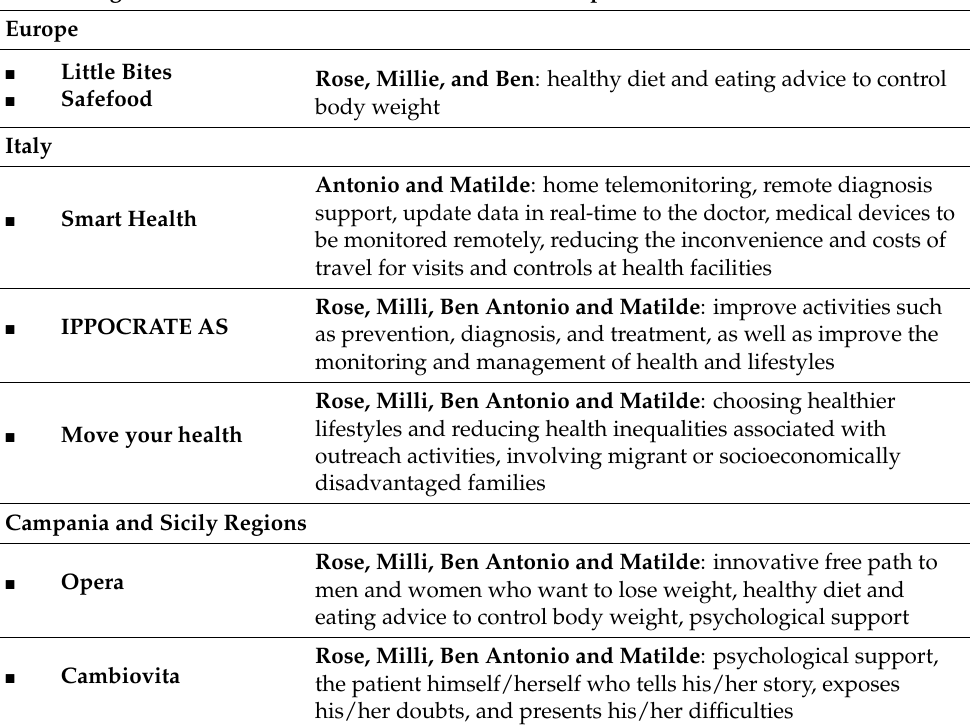
Table 2. Digital tools and Blueprint persona unmet needs Digital